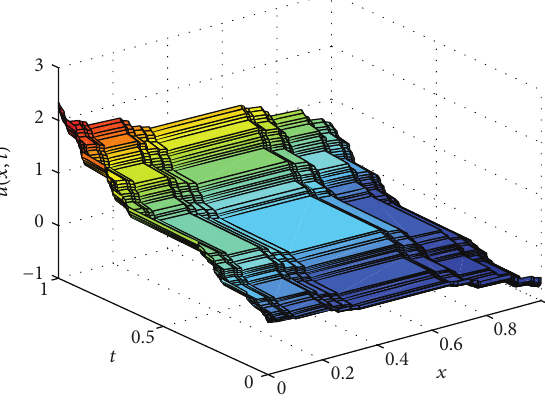
Figure 3: Graph of 𝑢(𝑥,𝑡) with the parameter 𝛼 = ln 2/ ln 3 . Figure 4: Graph of